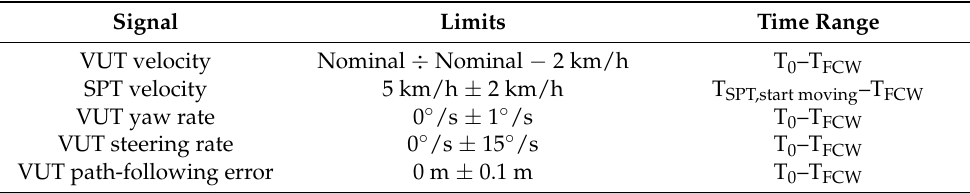
Table 3. Regulation limits for analyzed signals according to UNECE R152 CPNC.